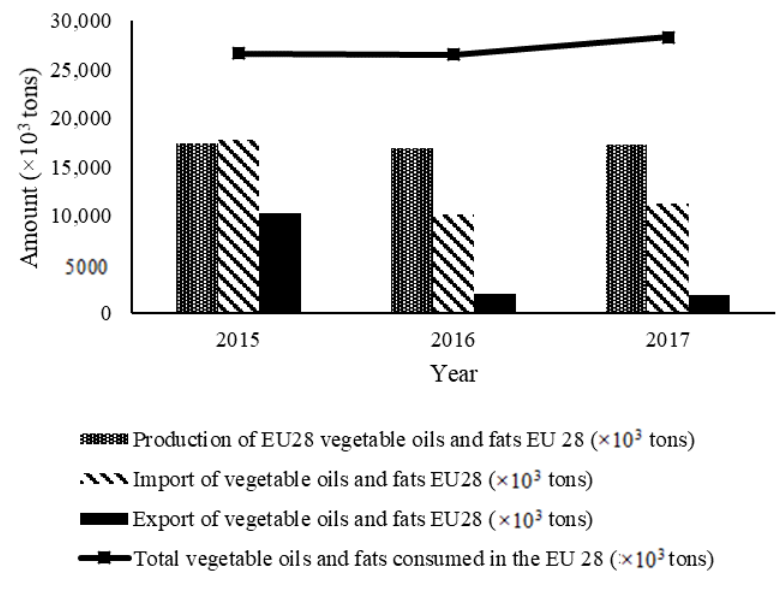
Figure 1. Data on new vegetable oils and fats in the European Union [3]. Table 1. Calculation of the total vegetable oils and fats consumed in the EU, in the years 2015–2018